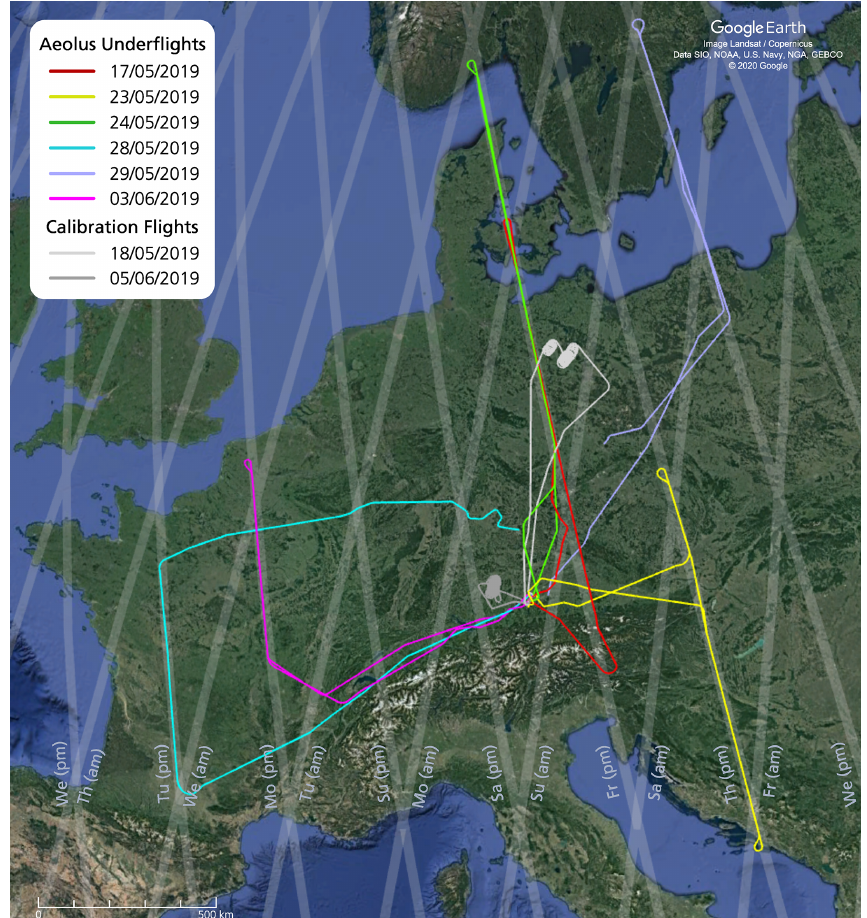
Figure 1. Flight tracks of the Falcon aircraft during the AVATARE campaign from 17 May to 5 June 2019 (background image © 2020 Google). Each colour represents a single flight. The Aeolus measurement swath is shown in grey. The satellite flying direction was always from south to north during the probed evening ascending